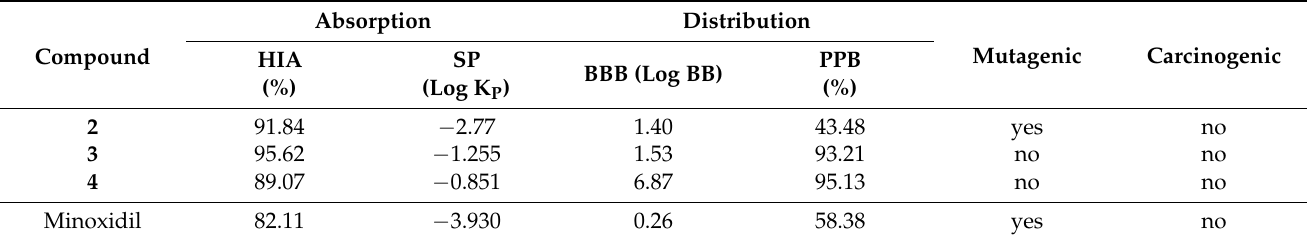
Table 8. Results of ADME-Tox